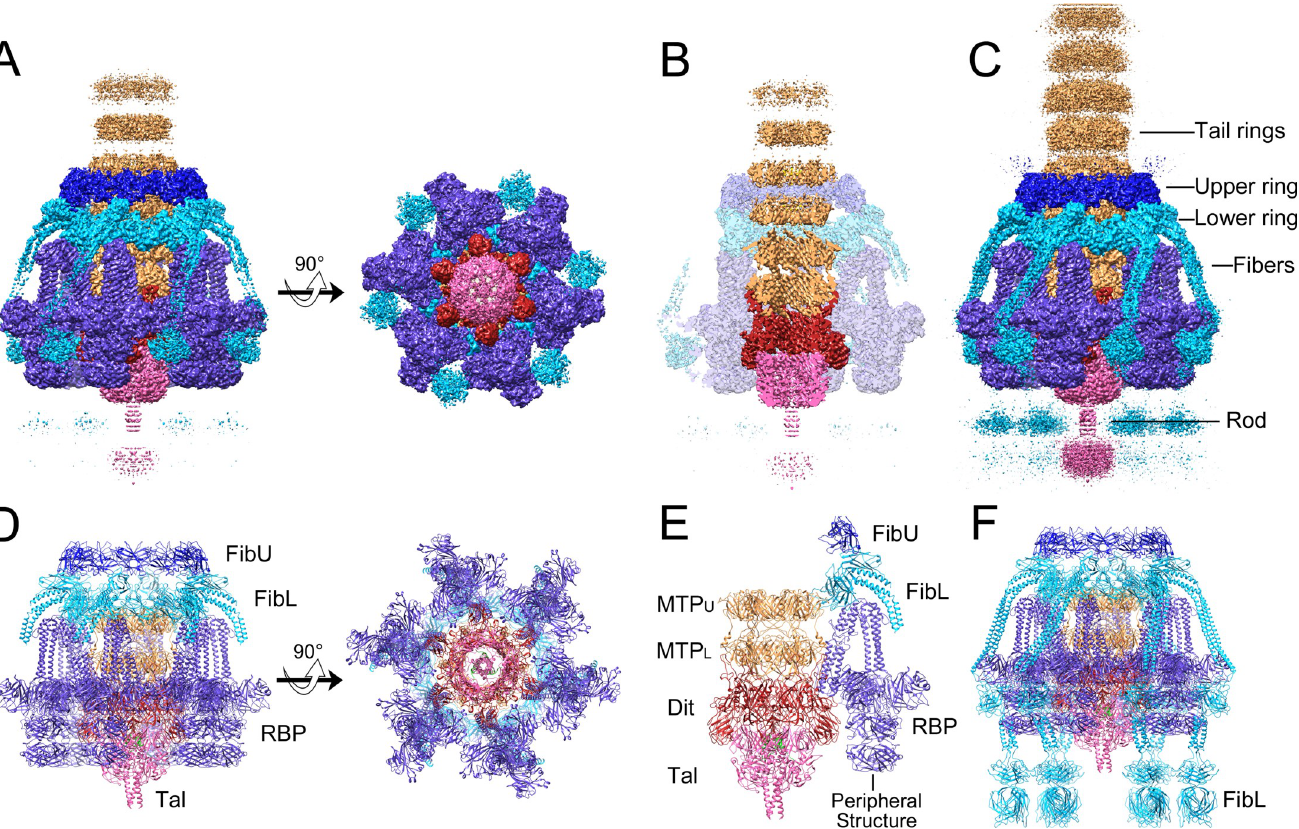
Fig 2. Reconstruction and modeling of the 80 α baseplate. (A) Isosurface representation of the 80 α baseplate C6 reconstruction at density cutoff level of 4.5 standard deviations above the mean (4.5 σ ), viewed from the side and bottom, segmented and color-coded according to the scheme in Fig 1. (B) Cutaway side view, showing the inside of the tail. Peripheral structures are shown as a transparent surface. (C) Side view at lower density cutoff level (3 σ ), showing the tail fibers, tail rings and rod density more clearly. (D) Ribbon representation of the atomic model of the entire baseplate, viewed form the side and bottom and colored as above. (E) Model with all except one peripheral structure removed to show MTP U , MTP L , Dit and Tal underneath. (F) Complete baseplate model showing the full-length FibL pseudo-atomic model.